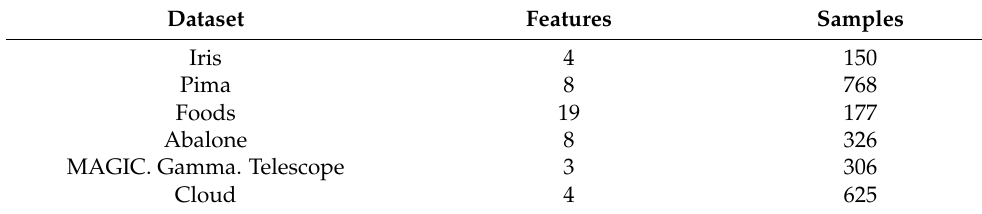
Table 1. Description of the experimental datasets.